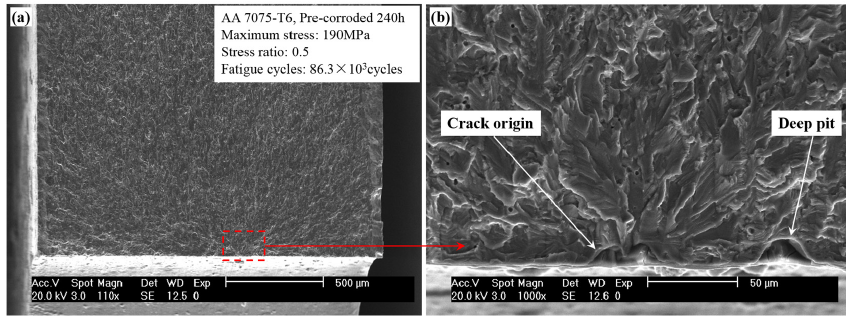
Figure 12. Typical SEM fractography with the fatigue crack initiating from two intersecting pits rather than the deeper pit. ( a ) Overall view of the fracture surface; and ( b ) local view of the crack